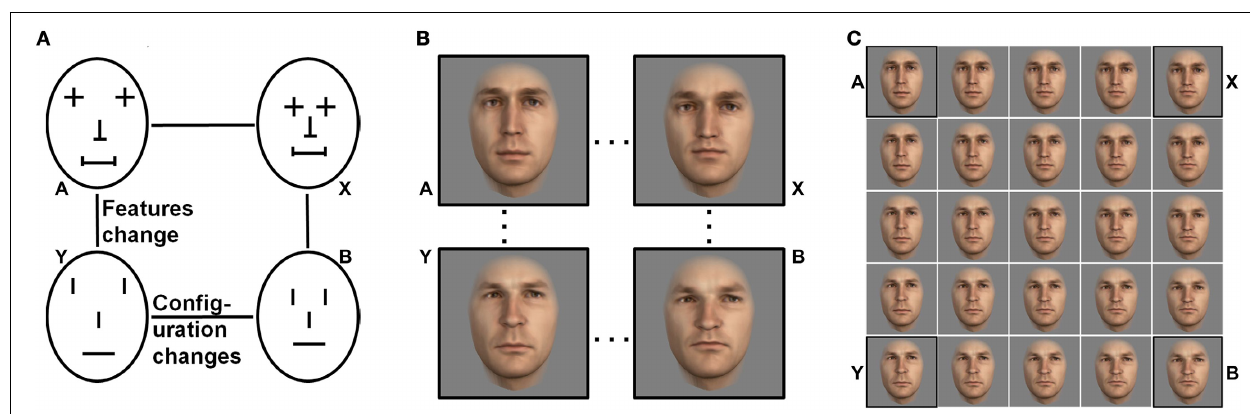
FIGURE 3 | (A) Schematic four faces which either differ in features (horizontal) or configuration (vertical). (B) The same design is applied to real faces of our face database. (C) Morphing between the four faces in (B) gives a set. Morphing steps between each row and column are equally spaced with 25%.